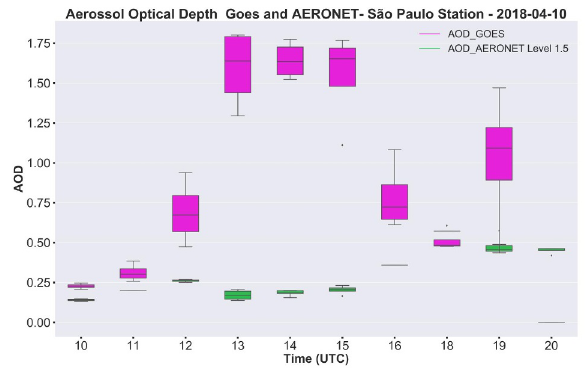
Figure 4: AOD retrievals from AERONET sunphotometer and Goes-16